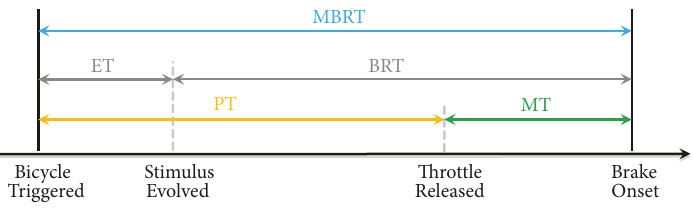
Figure 9: Segmentation of drivers’ prebrake behavior sequence.